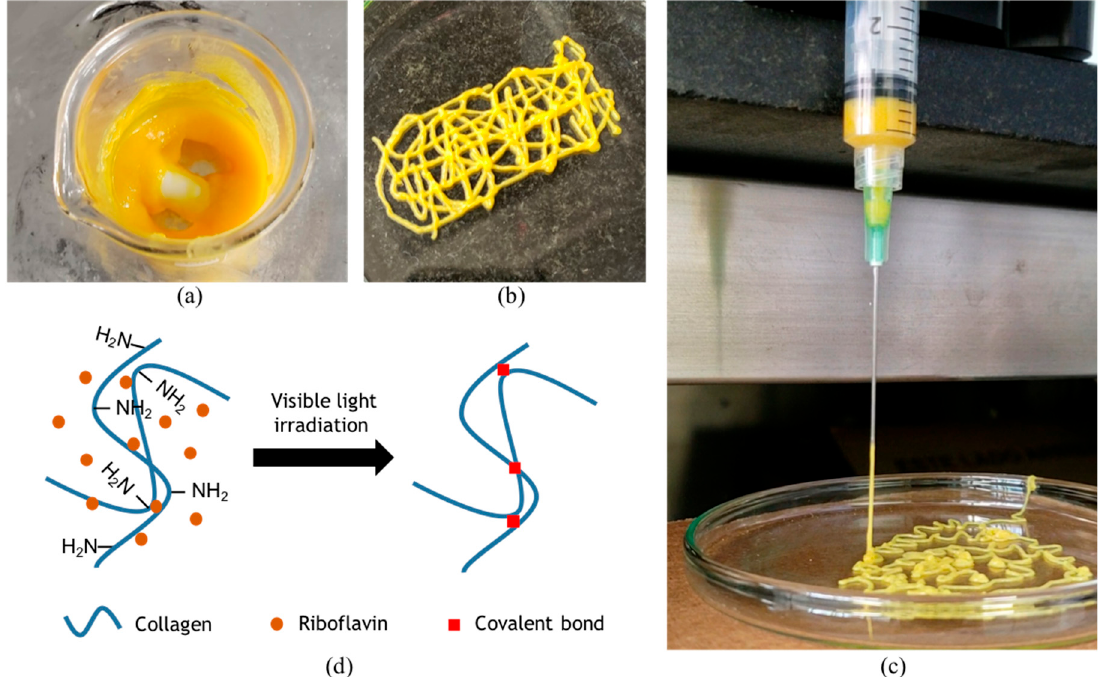
Figure 1. ( a ) Preparation of the 0.5% ( w / v ) riboflavin (RF) bioink and ( b ) its successful extrusion through a 21 G needle. ( c ) Filament formation during extrusion of the bioink through a 21 G needle. ( d ) Presumed photo-mediated crosslinking reaction thought to be occurring in the proposed bioinks.